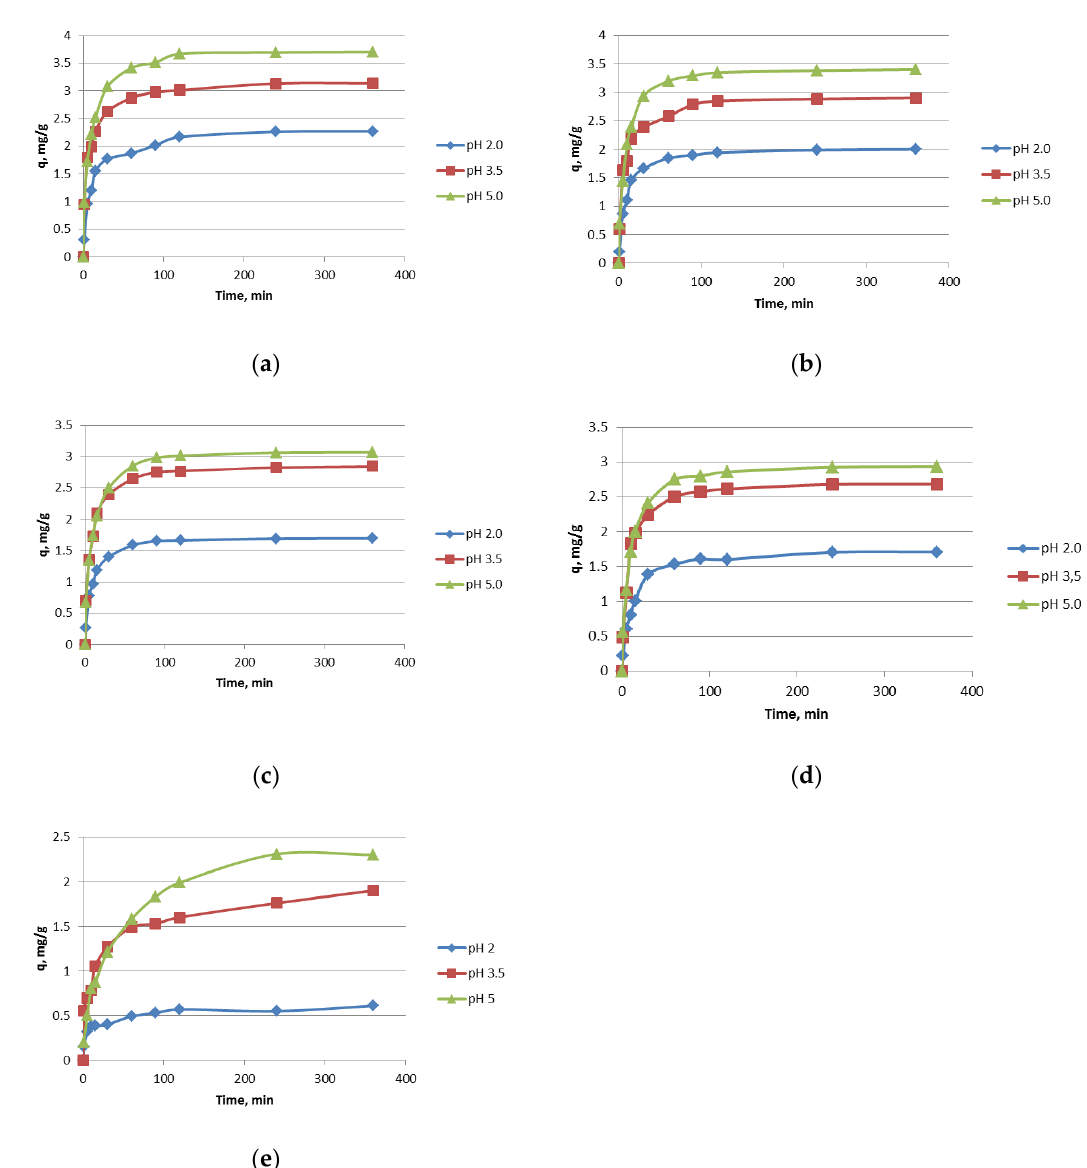
Figure 1. The effects of the contact time on the sorption capacity of ions in the pH range 2–5, ( a ) La(III),